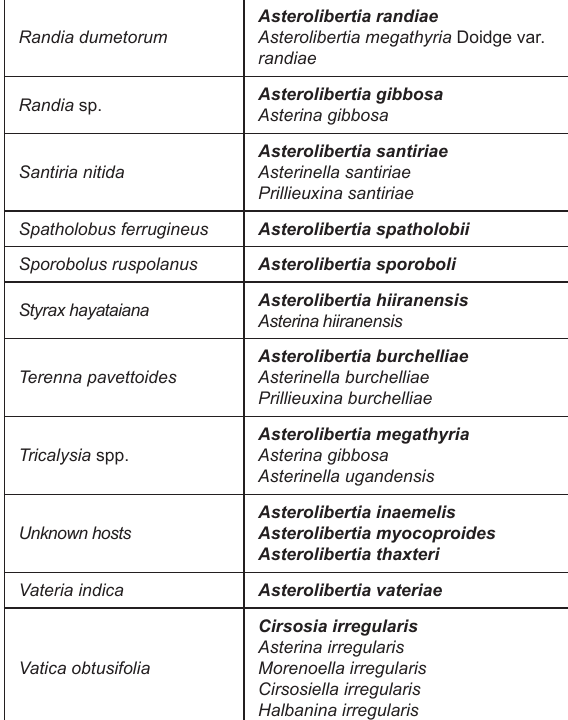
Table 1. Host and species